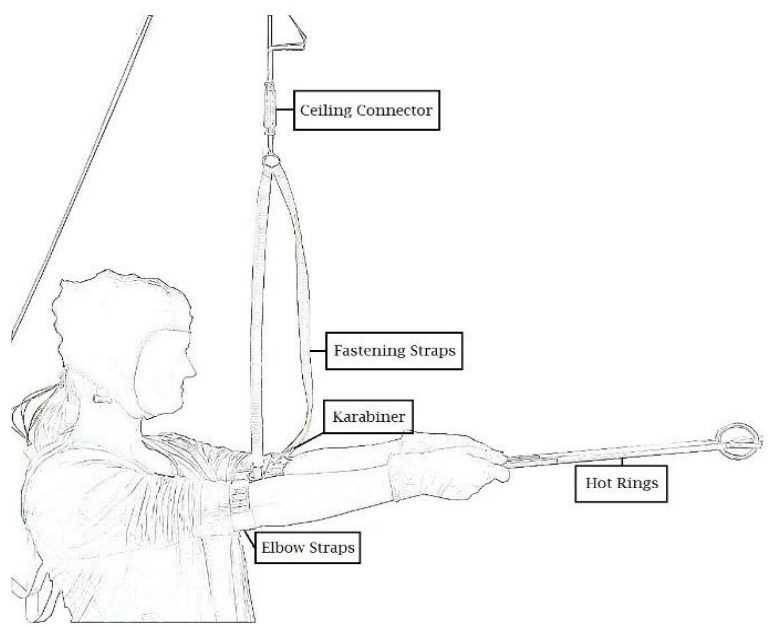
Figure 1. Illustration of the “hot rings task” (HRT; [18,31]).